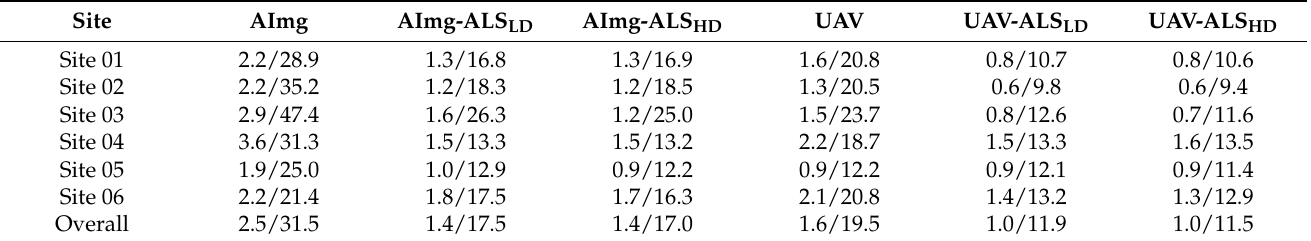
Table 5. The height accuracy (mean absolute error—MAE, in meters; percentage mean absolute error—%MAE, in percentages) of woody plant tree tops detected from six nDSMs based on UAV and airborne imagery and their combinations with HD and LD ALS DTMs compared to the reference based on the HD ALS